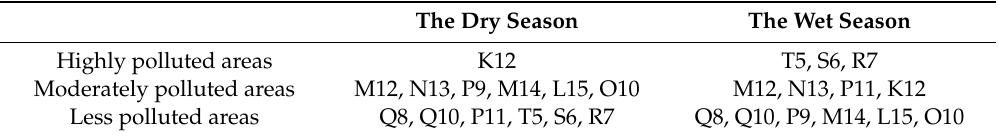
Table 5. Partition of sampling sites in the dry season and wet